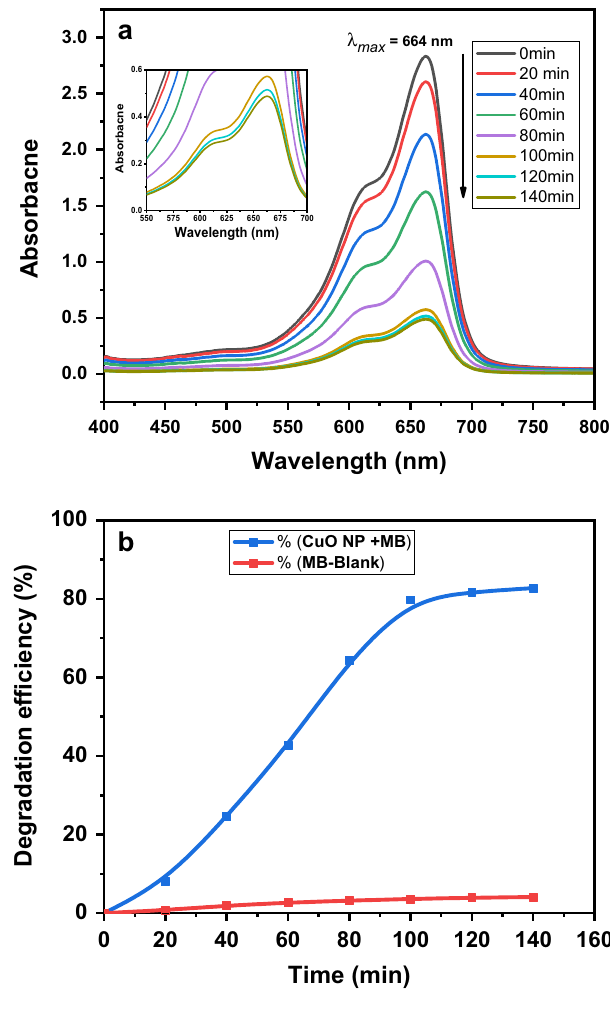
Figure 7. ( a ) Photocatalytic degradation of MB using CuO NS, ( b ) degradation efficiency (%) of MB. Both graphs were produced using OriginPro 2018